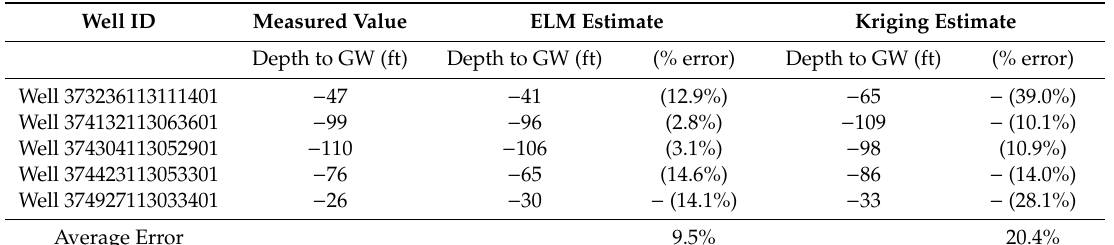
Table 2. Comparison of data imputed with the ELM model and data estimated using Kriging on 1 December